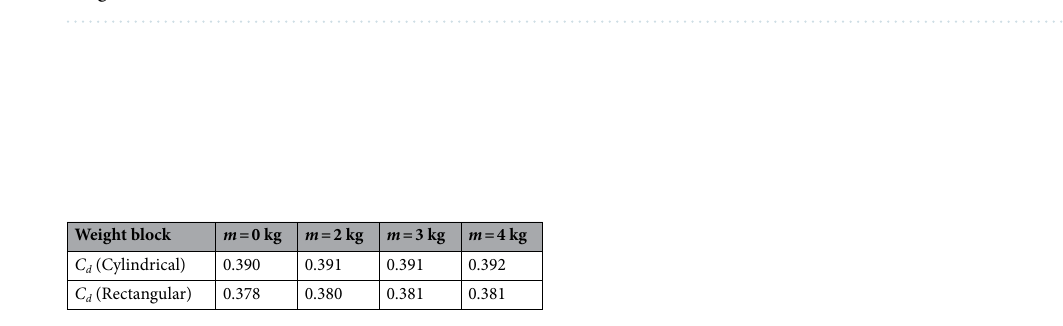
Figure 11. The variation law diagram of resistance coefficient of rectangular ore bin under different additional weights.